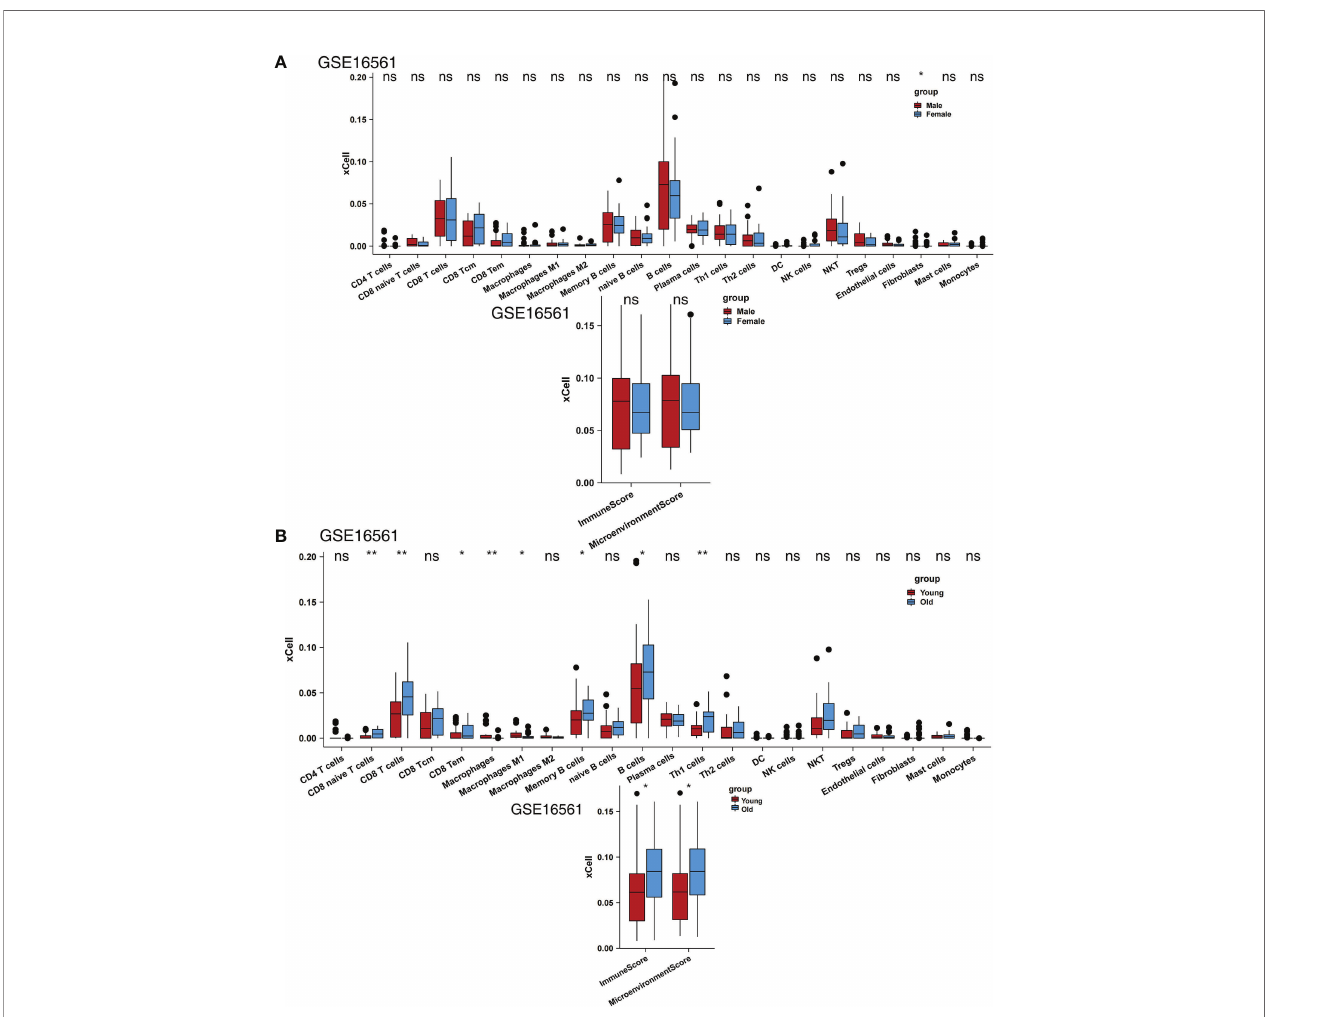
FIGURE 3 | Comparison of the immune cells between clinical subgroups. (A) Comparison of the scores for immune cells estimated by the xCell algorithm between males and females in GSE16561. (B) Comparison of the scores for immune cells estimated by the xCell algorithm between young and old individuals in GSE16561. (*P < 0.05, **P < 0.01; Mann-Whitney U test). ns, not signi fi